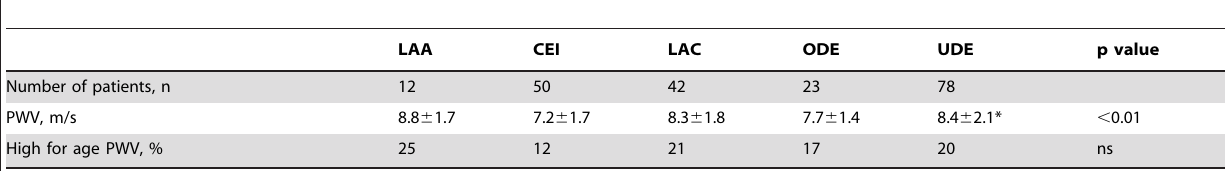
distal distance between the sternal notch and the femoral site were measured precisely. Carotid-femoral PWV was calculated as distance (D) in meters between the 2 recording sites divided by transit time (TT) in seconds (PWV = D/TT) [4]. All PWV values were corrected for mean blood pressure. High for age PWV was taken as PWV higher than age-adjusted normative values based on a large study of 4001 healthy subjects (Figure 1) [16,17]. The carotid intima-media thickness (IMT) was measured by carotid ultrasound as previously published [10]. Carotid plaque was defined as focal IMT . 1.5 mm [10,18]. Table 2. PWV and prevalence of high for age PWV in stroke subtypes according to the TOAST classification.